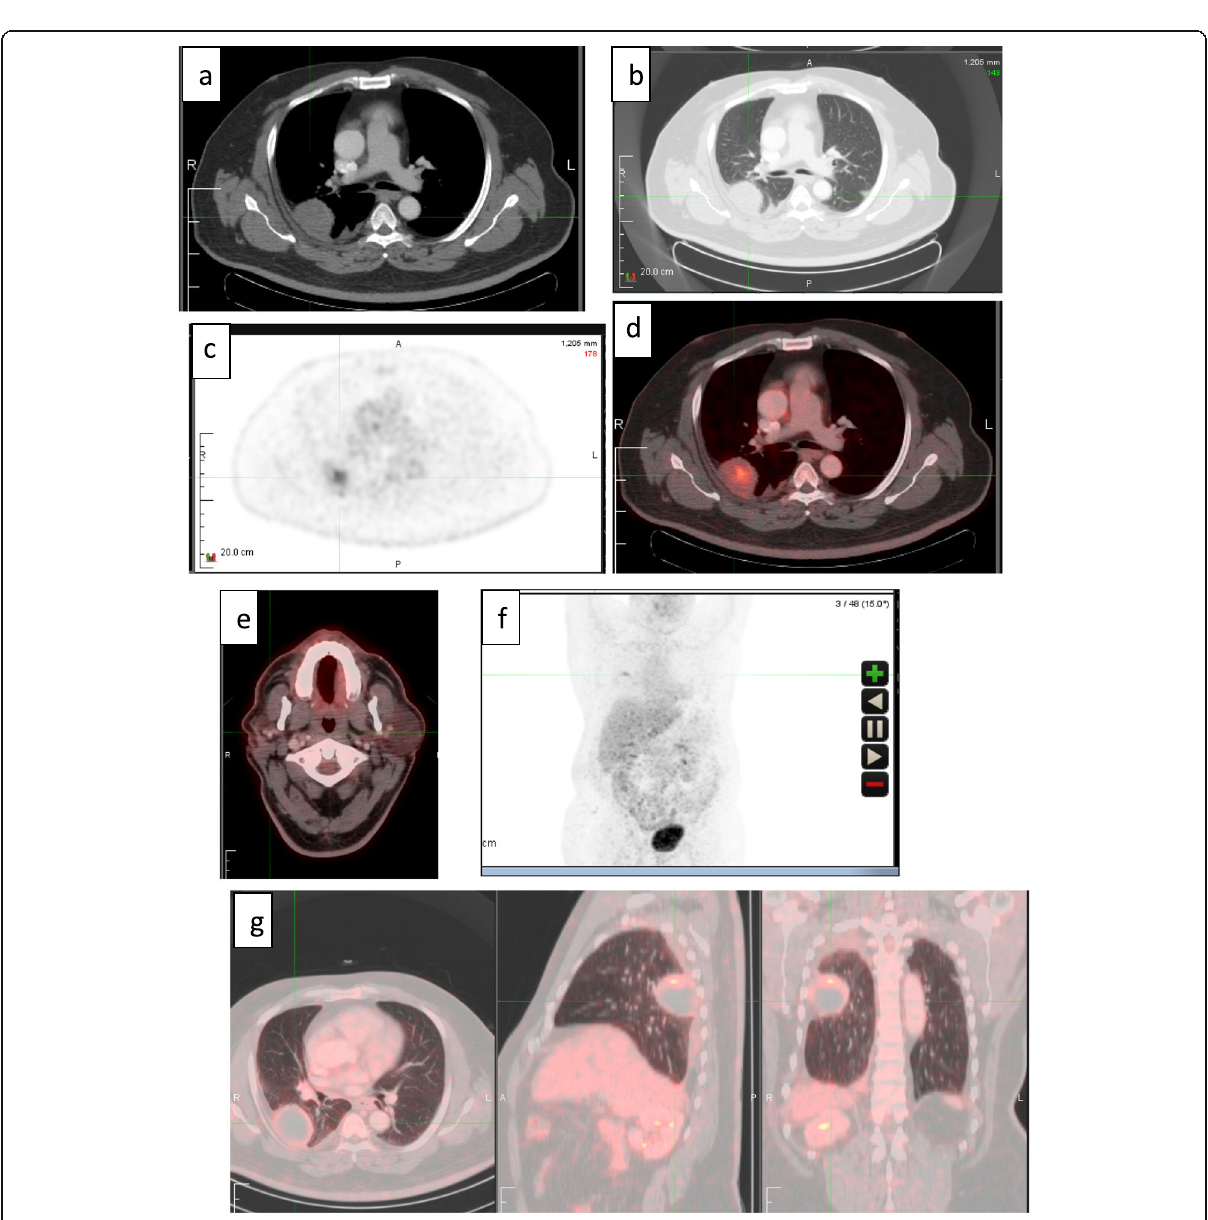
Fig. 3 A 56-year-old male underwent left nephrectomy for renal cell carcinoma papillary type, grade II and superficial parotidectomy for papillary cytadenoma lymphomatosum. CT ( a , b ), PET ( c ), and PET/CT ( d ) revealed metabolically active necrotizing right pleural-based malignant pulmonary mass in the apical segment of right lower measuring 6.2 × 5 cm SUVmax 4.8, no regional lymphadenopathy or distant metastasis. CT- guided core biopsy revealed necrotizing round cell neoplasm. PET/CT ( e ) reveals clear operative beds with no metabolically active residual/ recurrent parotid tumor. MIP PET ( f ) image confirm the previous findings. PET/CT ( g ) shows newly detected lung cancer in 3